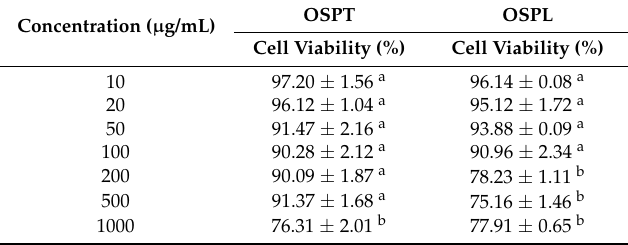
Table 2. Percentage viability of C2C12 cells treated with different concentrations of OSPT and OSPL.